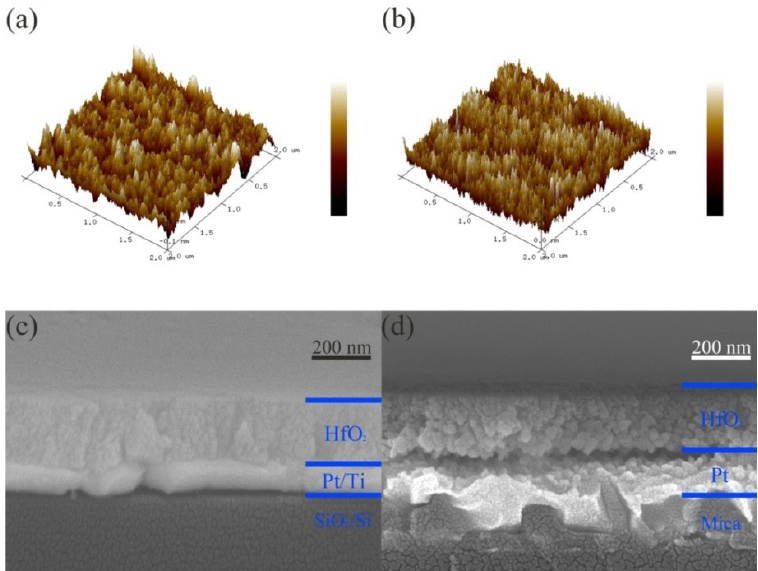
Figure 2. ( a,b ) Atomic force microscopy patterns of HfO 2 thin films in S1 and S2 devices, respectively; ( c,d ) typical cross-sectional scanning electron microscope images of S1 and S2, respectively.